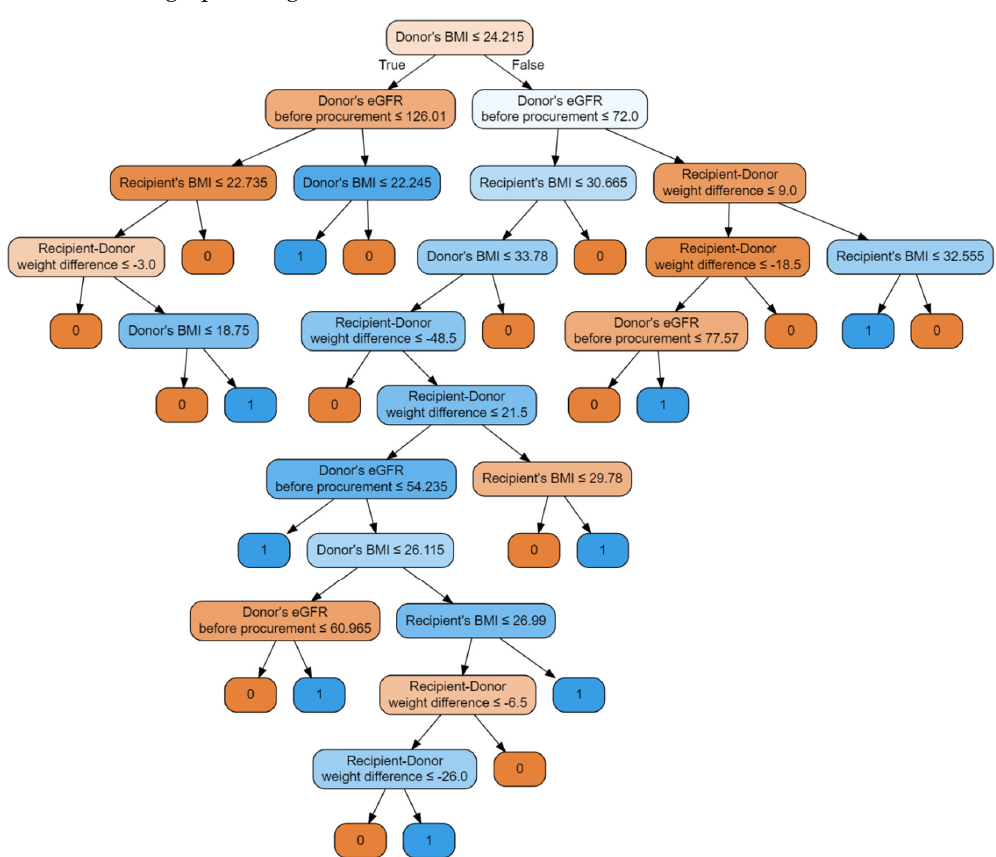
Figure 9. Random forest classifier with input features: donor’s BMI, donor’s eGFR before procurement, recipient–donor weight difference, recipient’s BMI.